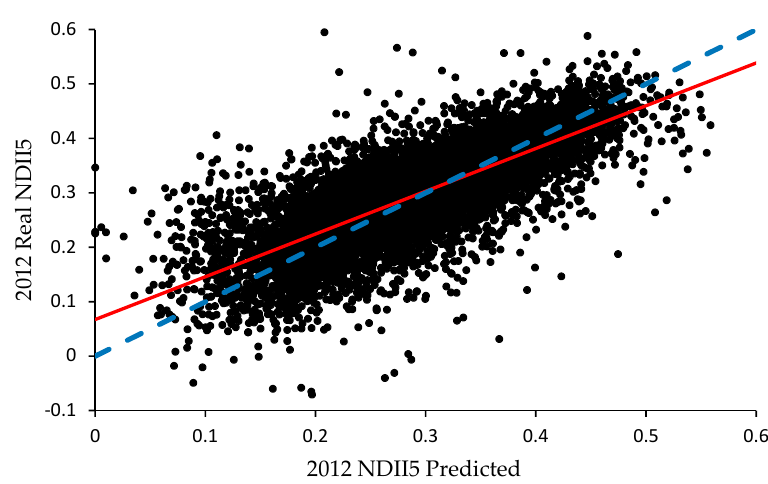
Figure 12. The comparison of the predicted NDII5 and the real NDII5 maps of the study area in the year 2012. Places A and B are the two same regions zoomed in.